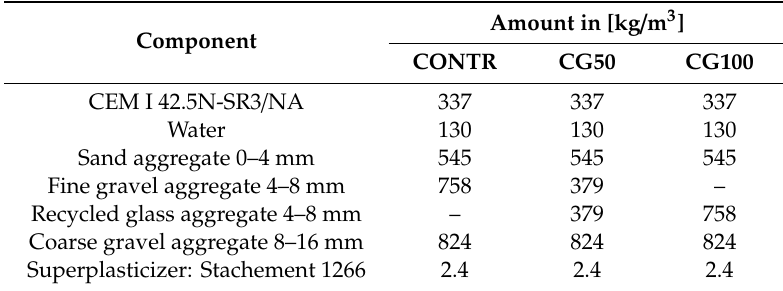
Table 2. Composition of the concrete